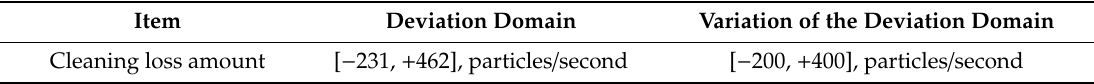
Table 1. Variation range of the cleaning